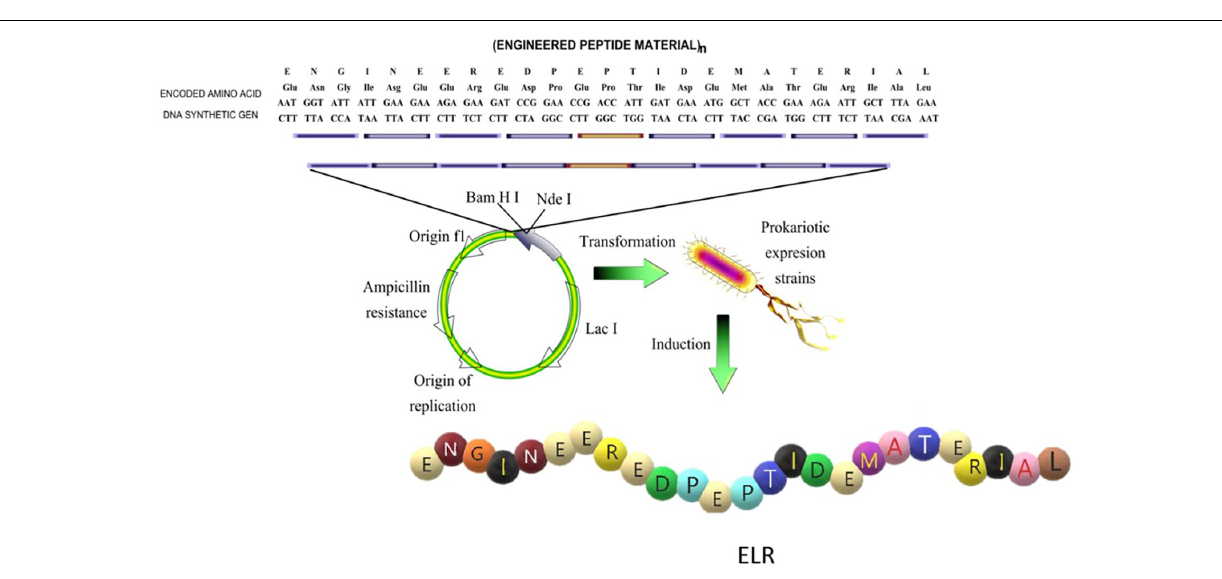
FIGURE 2 | Schematic representation of the design of the sequence and production of an elastin- like recombinamer (ELR). Reproduced with permission from (doi.org/10.1016/j.addr.2018.03.003), copyright